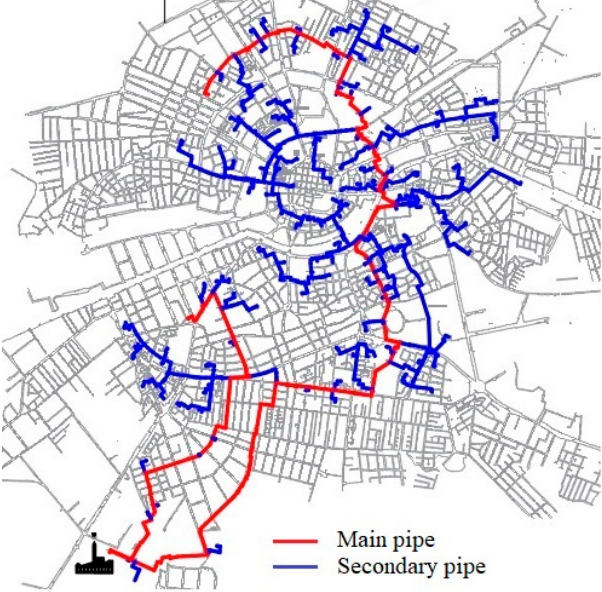
Figure 14. Scheme of the Timisoara heat transmission network.